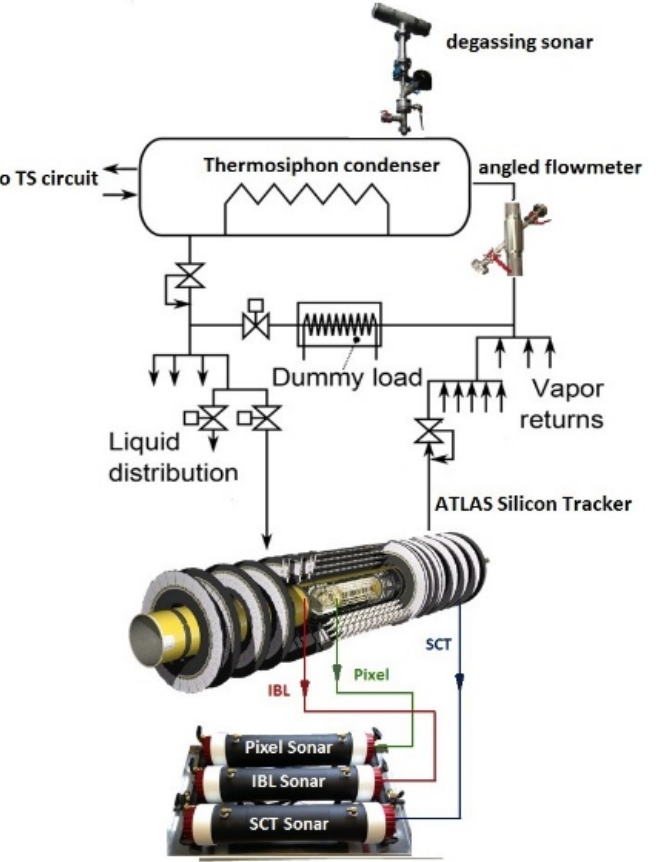
Figure 1. Installations in the ATLAS Inner Detector. Three sonars monitor the N 2 envelopes of the Pixel , SCT , and IBL silicon tracker sub-detectors, while a degassing sonar and an angled flowmeter monitor the 60 kW thermosiphon (TS) C 3 F 8 evaporative coolant recirculator.